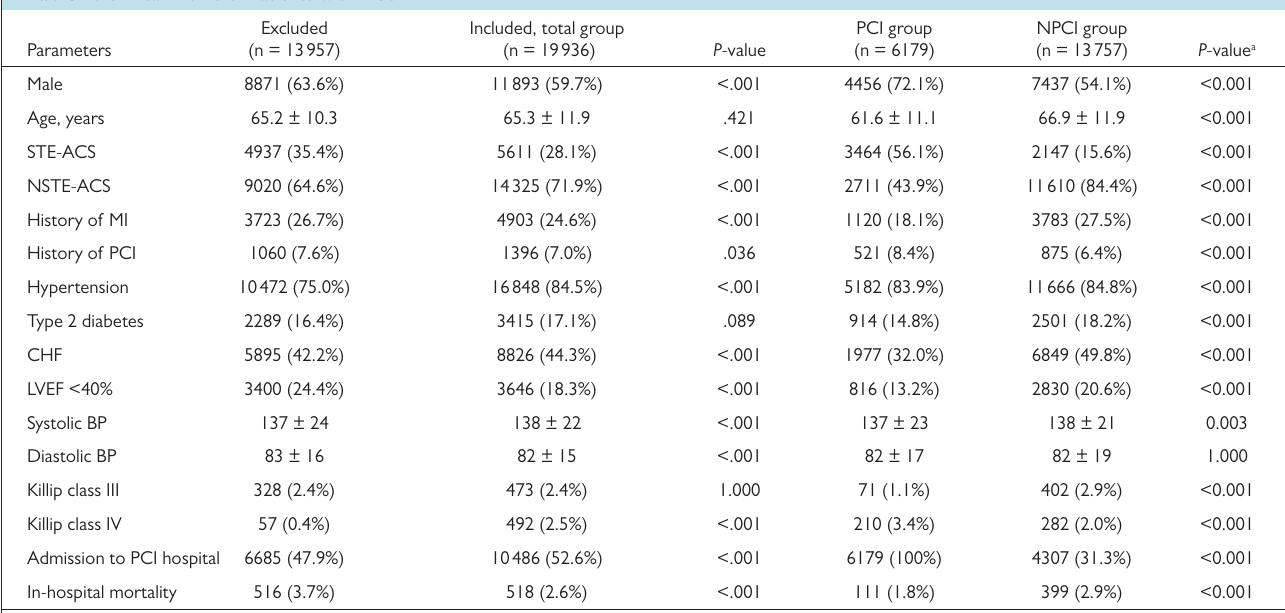
Table 1. Clinical Profile of Patients with ACS